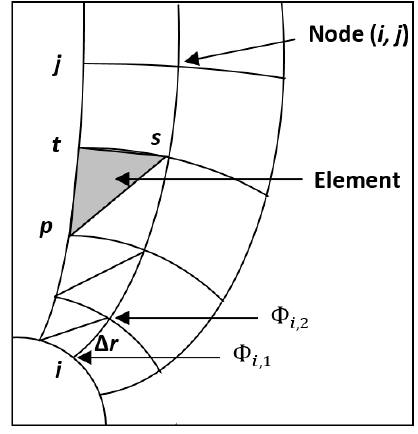
Figure 6. Electric-field flux lines extending from the stressed discharge wires to the collecting plates of WDESP.